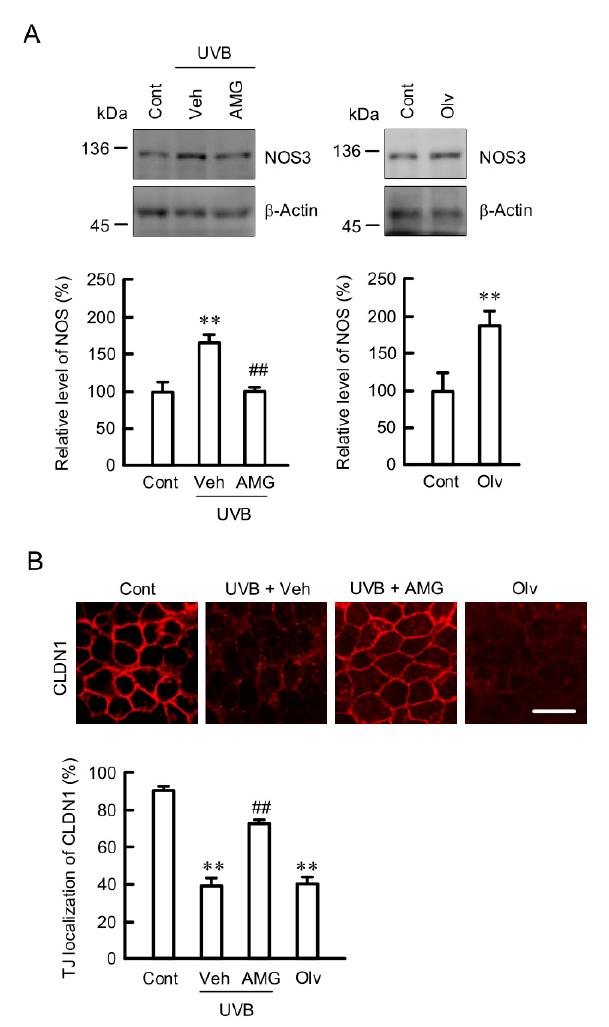
Figure 8. Involvement of TRPV1 in the UVB-induced destruction of TJ. ( A ) After exposing to weak UVB, the cells were incubated for 6 h in the absence (Veh) and presence of 10 μ M AMG9810 (AMG). In the case of UVB-untreated samples, cells were incubated for 6 h in the absence (Cont) and presence of 1 μ M olvanil (Olv). The cell lysates were applied to 7.5% SDS-PAGE followed by blotting with anti- NOS3 and anti- β -actin antibodies. The full-length blot images are shown in Figure S6. The level of NOS3 is represented as a percentage Cont. n = 4. ( B ) The cells were immunostained with anti-CLDN1 antibody. Scale bar indicates 10 μ m. The fluorescence values of CLDN1 at the TJ are shown as a percentage of the total fluorescence values. n = 6. ** p < 0.01 and NS p > 0.05 vs. Cont. ## p < 0.01 vs. Veh.